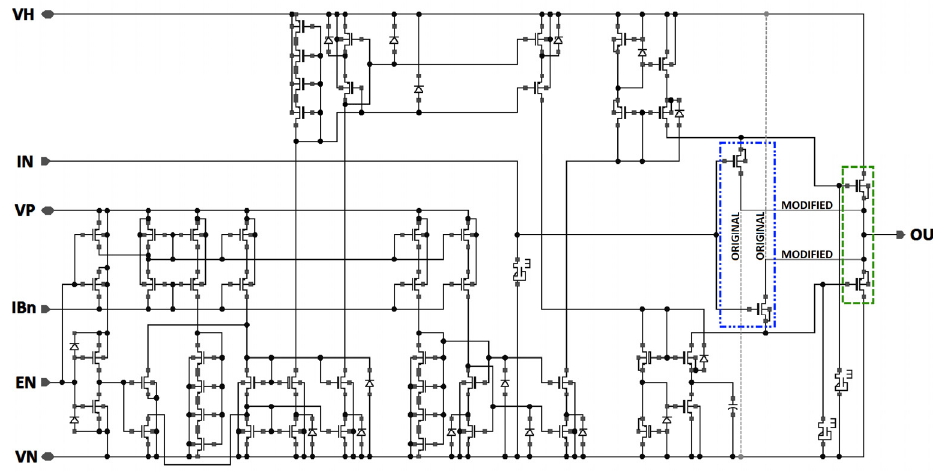
Figure 4. Complete schematic of the gate follower.